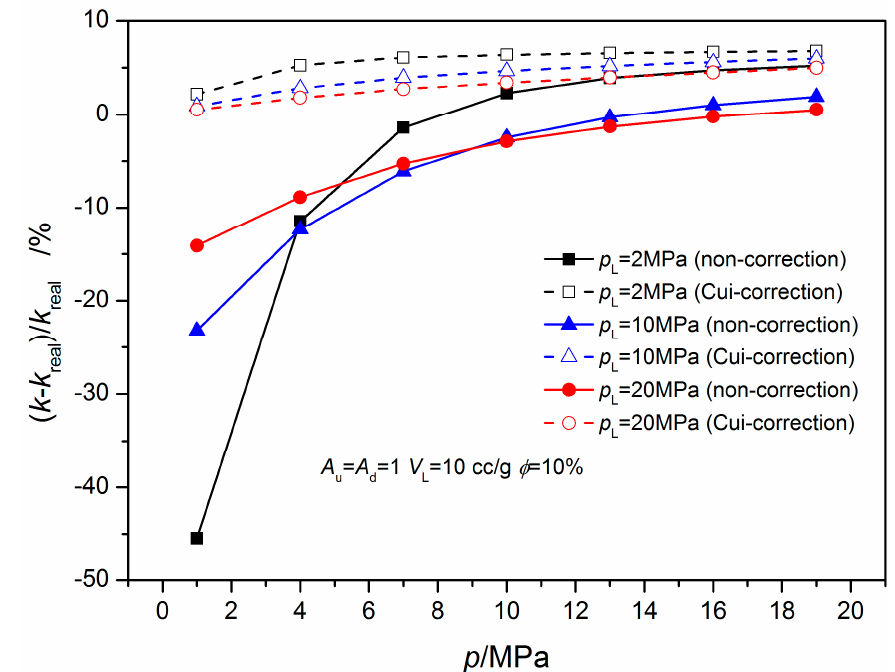
Figure 13. The influence of p L on the tested permeability.